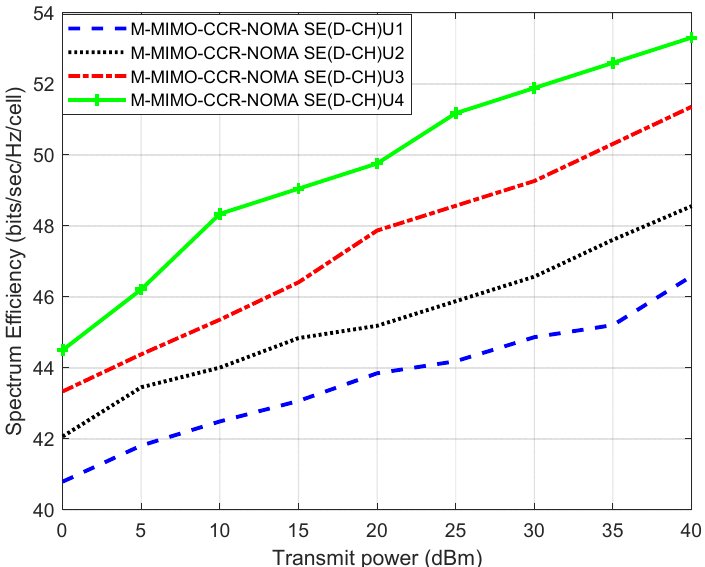
Figure 12. SE versus transmitting power for 4 users’ 128 × 128 M-MIMO DL NOMA PD with D-CH CCRN.